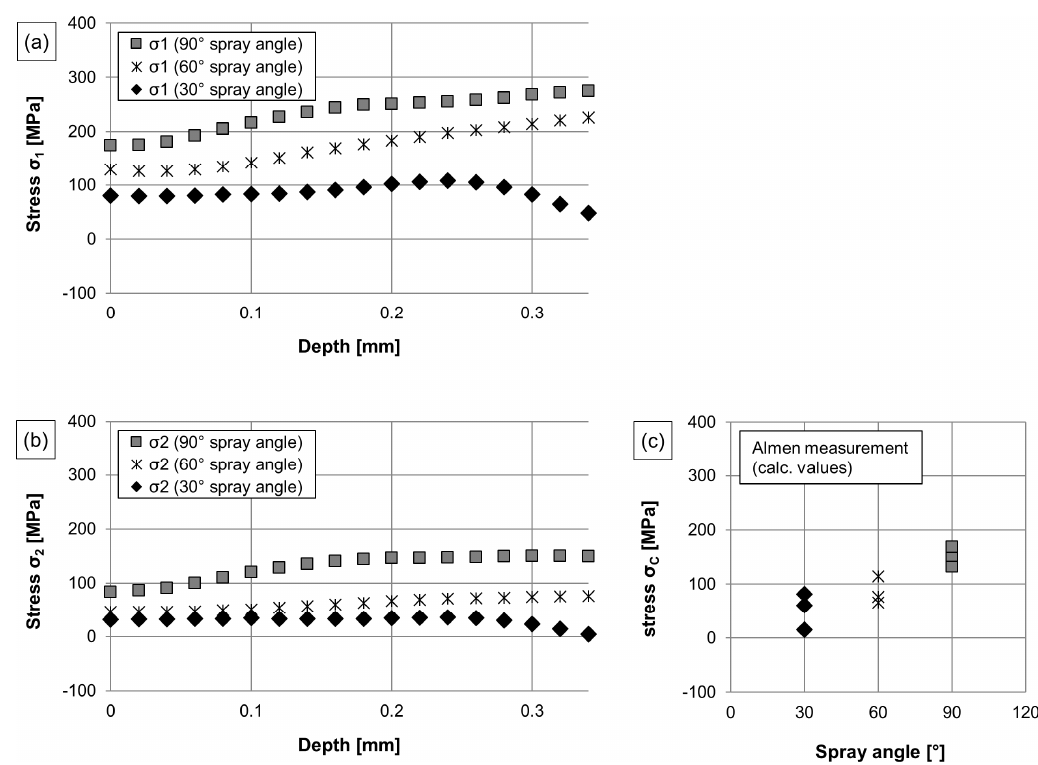
Figure 3. Residual stress distribution along coatings produced by different spray angles determined by using the bore hole drilling strain gage method ( a , b ), and calculated stress state in coatings produced by different spray angles using the curvature method ( c ).